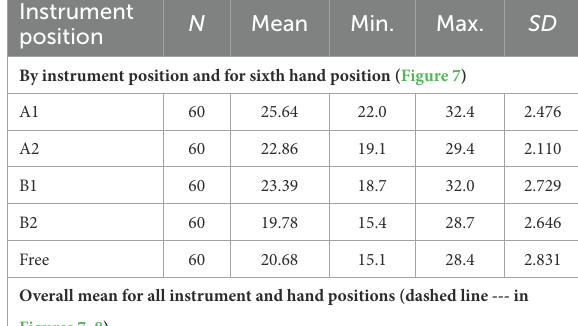
TABLE 4 Descriptive statistics for Reference Angle α (elbow compensation movement for the entire 16-s tune. Instrument